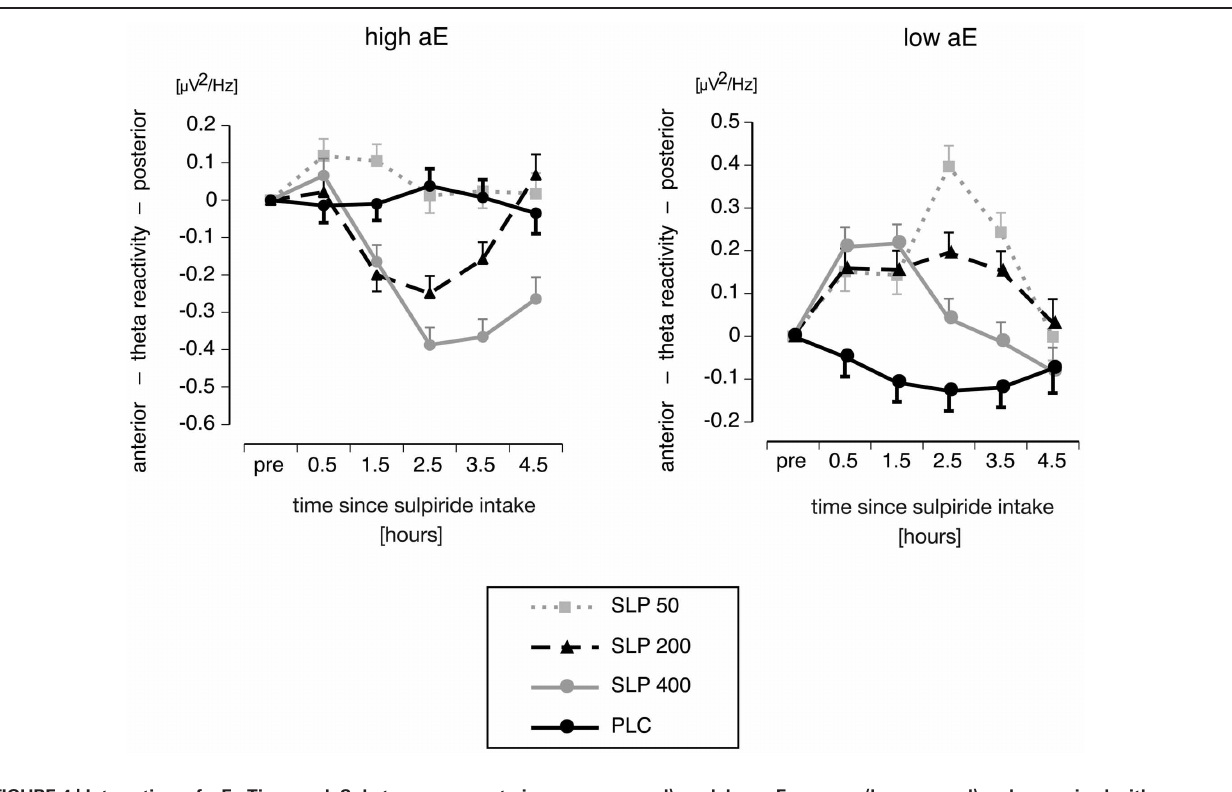
FIGURE 4 | Interaction of aE, Time and Substance on posterior vs. anterior theta reactivity ( M and SEM values) focusing on time courses of posterior vs. anterior theta reactivity for high (upper